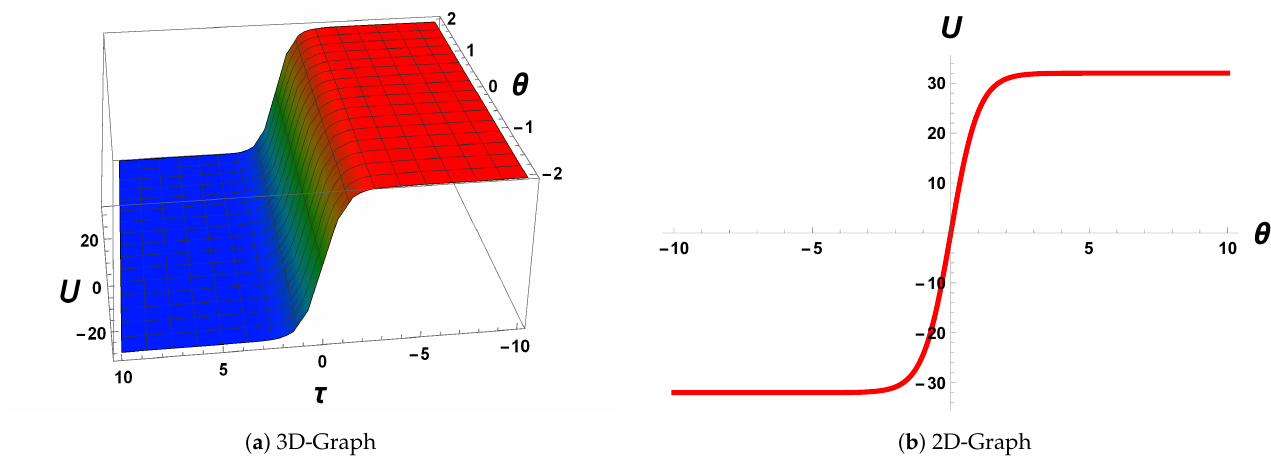
Figure 4. Diagrams a − 3 D and b − 2 D representation of U 5 ( θ , τ ) for l 1 = 1.5, l 2 = 0.75, δ = 0.5, γ 1 = 0.50, γ 2 = 0.50, and γ 3 = 0.75.